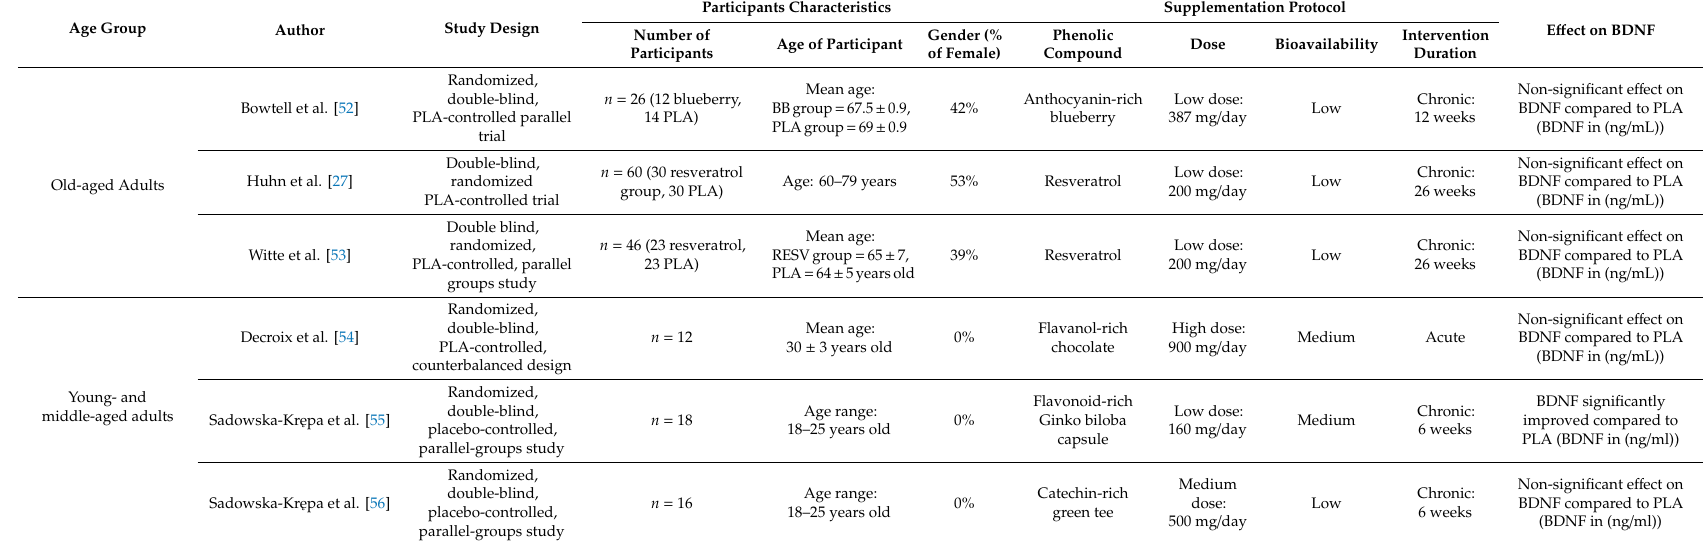
Table 3. E ff ects of (poly)phenols-rich supplementation on brain-derived neurotrophic